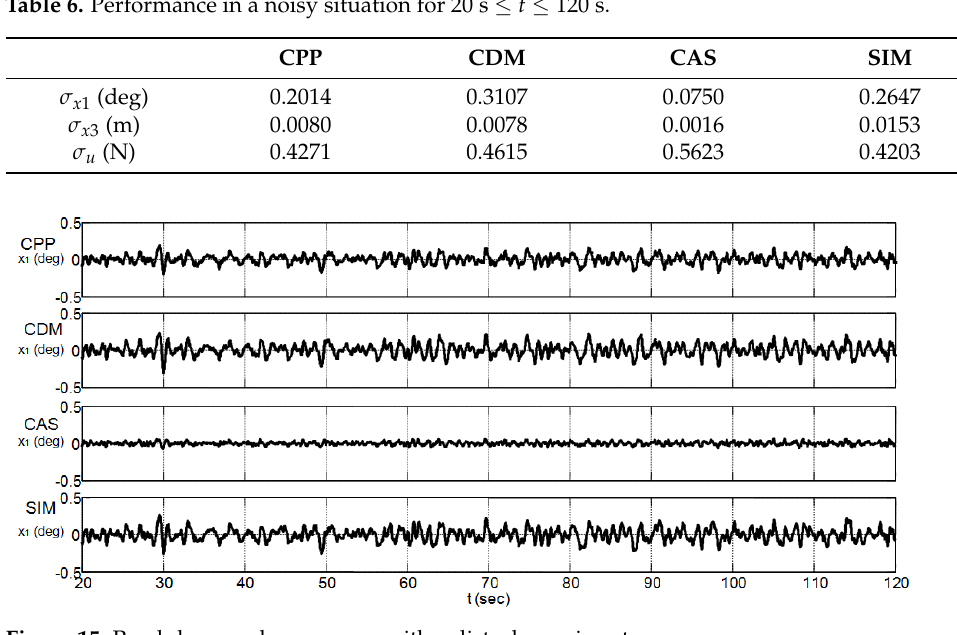
Figure 15. Pendulum angle responses with a disturbance input.